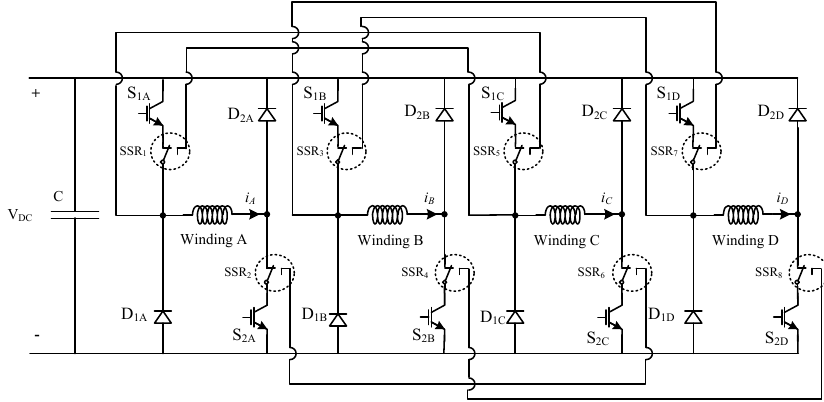
Figure 4. Proposed Fault tolerant scheme for the drive used to supply the 8/6 SRM.